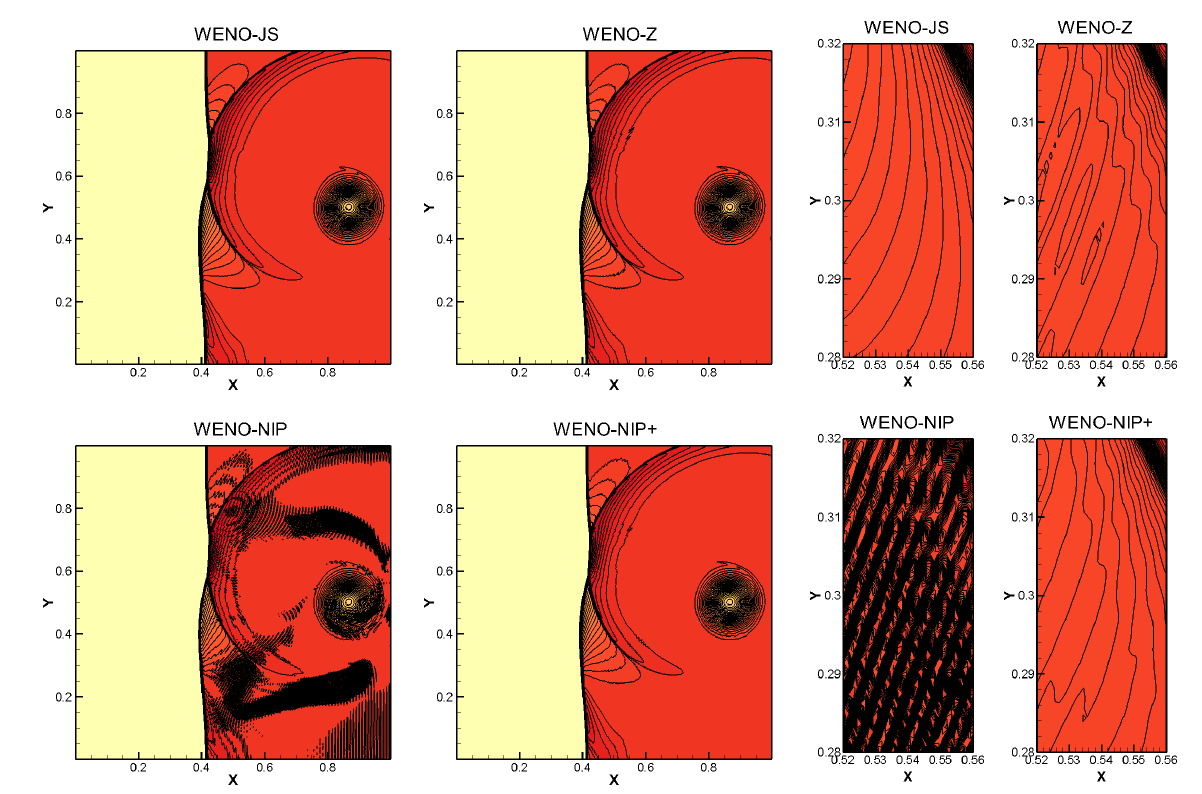
Figure 23. Numerical solutions of the shock-vortex interaction problem using 800 × 800 cells at t = 0.60. Left upper corner of the first two columns, WENO-JS. Right upper corner of the first two columns, WENO-Z. Left lower corner of the first two columns, WENO-NIP. Right lower corner of the first two columns, WENO-NIP+. Left upper corner of the last two columns, zoomed-in view of WENO-JS. Right upper corner of the last two columns, zoomed-in view of WENO-Z. Left lower corner of the last two columns, zoomed-in view of WENO-NIP. Right lower corner of the last two columns, zoomed-in view of WENO-NIP+.